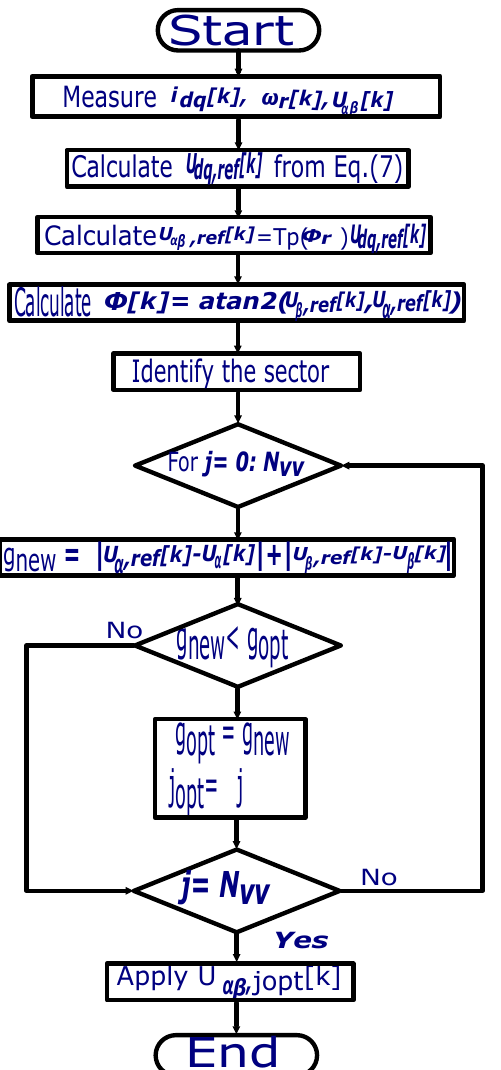
Figure 5. Flowchart of the Proposed Finite-Control-Set Model Predictive Control with